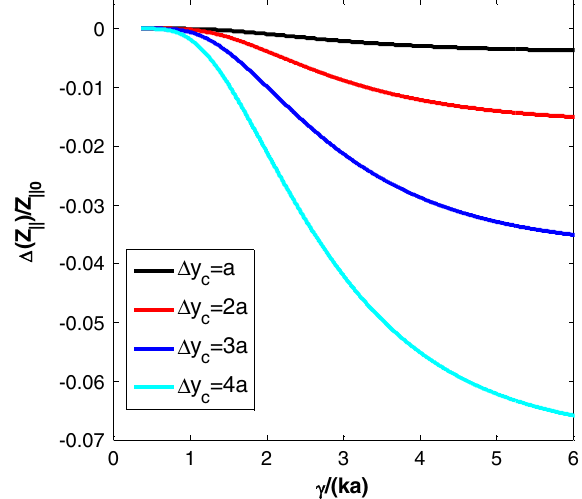
FIG. 6. Effect of vertical beam axis offset ( Δ y ) on the on-axis c LSC impedance of a parallel-plate chamber with h ¼ 10 a . The relative impedance difference Δ Z ∥ is normalized by the on-axis ¼ 0 . The impedance at long LSC impedance Z ∥ 0 with Δ y c wavelength is slightly reduced when the beam axis has small vertical offsets.